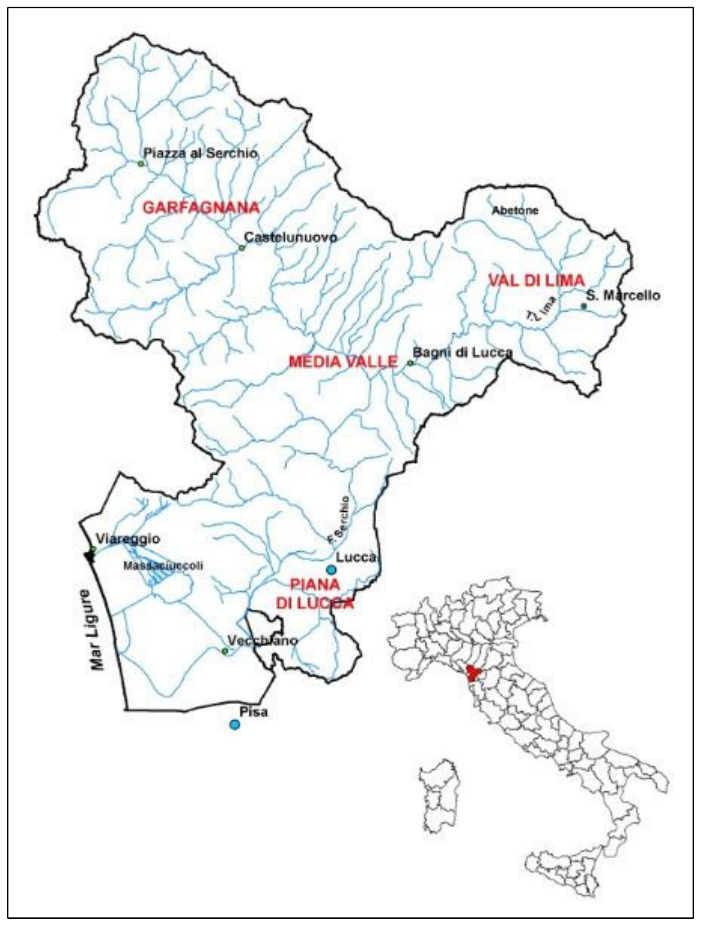
Figure 1. The Garfagnana Territory, Located in the Northwest Corner of the Province of Lucca,